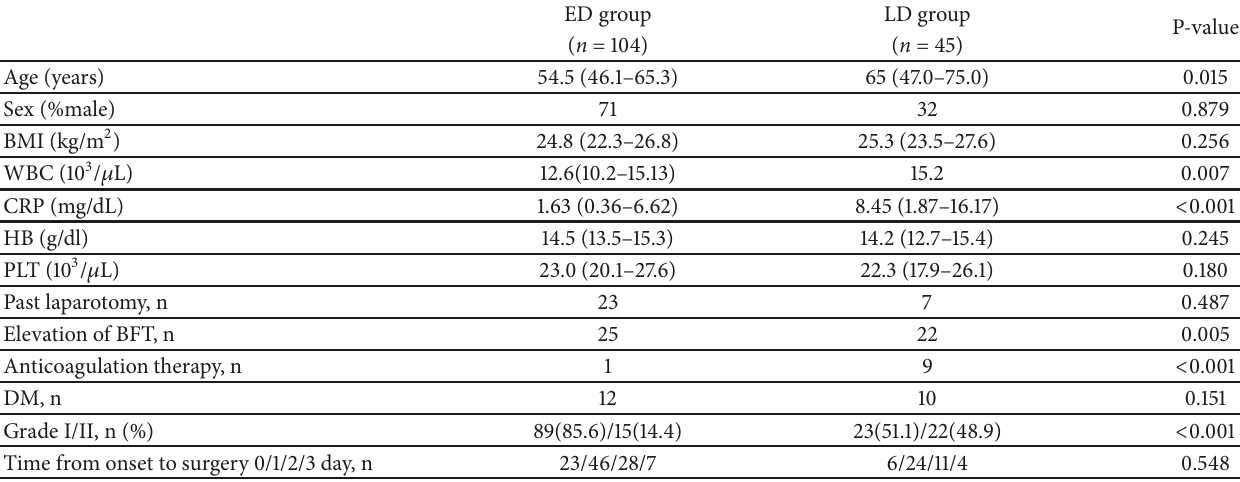
Table 1: Patients’ characteristics and univariate analysis for preoperative factors.